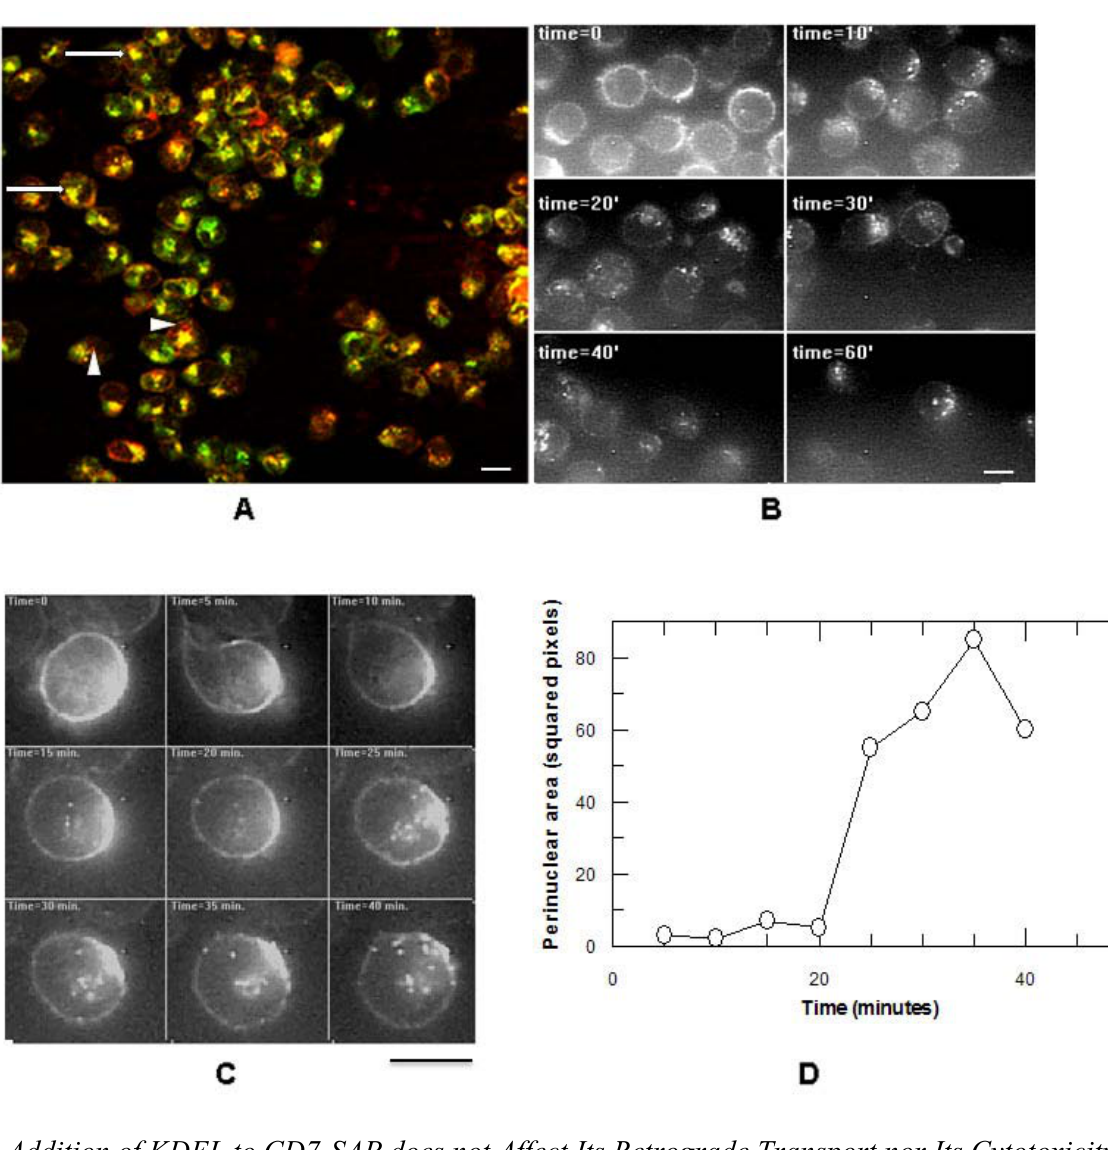
Figure 1. Kinetics of internalization of CD7-SAP and intracellular co-localization with T ricin revealed by fluorescence microscopy. ( A ) Confocal merged image obtained on fixed F ITx). ( B ) Kinetics of cellular internalization of cells (Green= Ricin, Red = CD7-SAP T CD7-SAP ITx on cells (placed at 37 °C) fixed at shown intervals after pre-incubation at T 4 °C. ( C ) Kinetics of cellular internalisation of CD7-SAP ITx in living cells at 37 °C at T the shown time intervals after pre-incubation at 4 °C. ( D ) time course of ITx accumulation ) in living cells.The reference bars represent 10  (CD7-SAP T